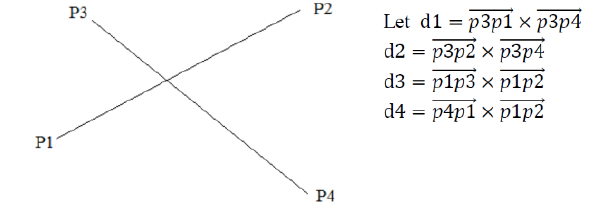
Figure 5. Line segment intersection